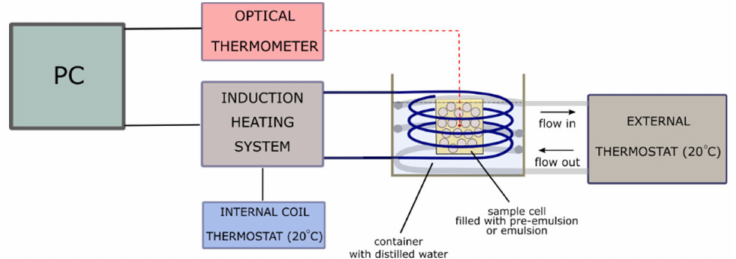
Figure 3. The scheme of the experimental setup for calorimetric measurements of magnetite-stabilized emulsions under an AC magnetic field. The measurement cell filled with either pre-emulsion or emulsion was placed in the induction coil. The induction coil was immersed in the thermostated container with distilled water where the temperature of 20 ◦ C was maintained by an external thermostat. Additionally, the induction was water-cooled to e ffi ciently diminish the e ff ect of heating of the